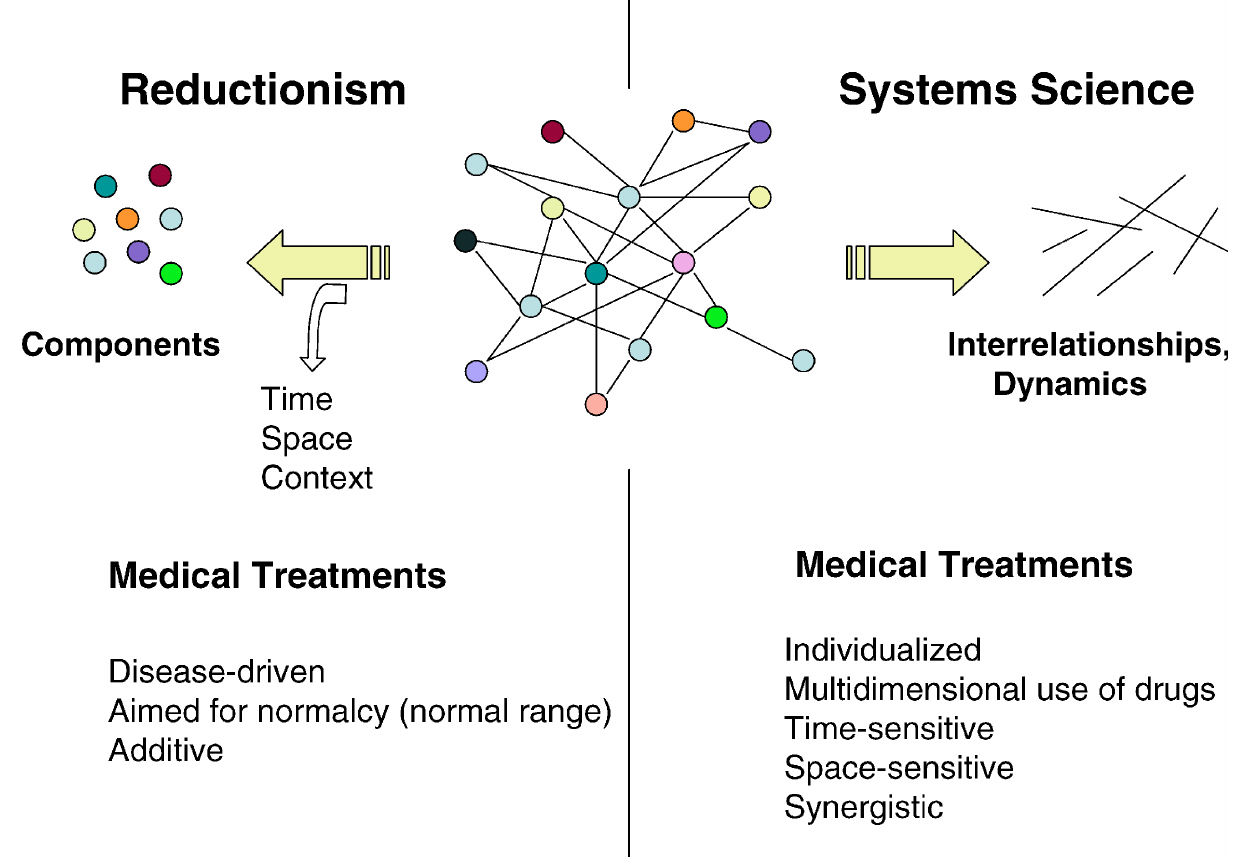
Figure 2. Schematic illustration of the core differences between reductionism and systems science, when analyzing the properties of a